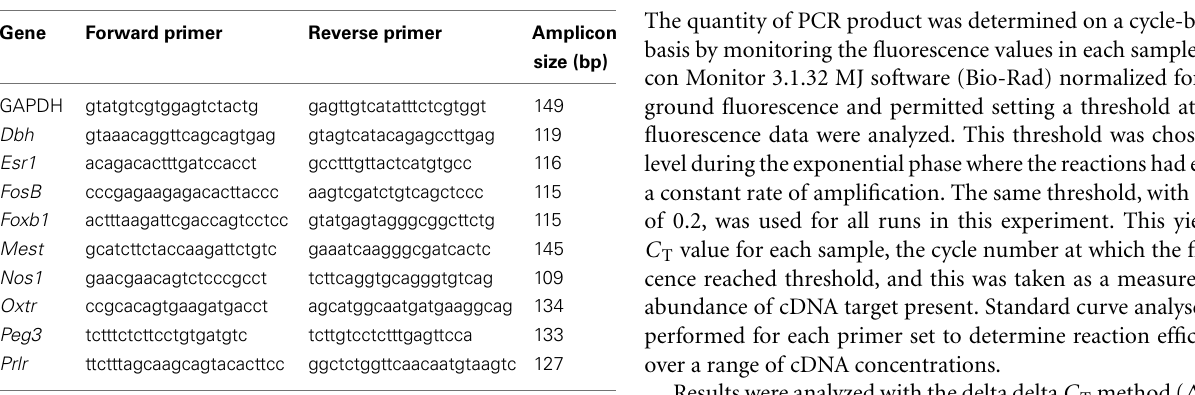
FIGURE 1 | Schematic of mouse olfactory circuits. Main olfactory pathway is shown in red, accessory olfactory pathway in blue, back projections in green, and intracortical projections in purple. Regions highlighted in gray were analyzed in this study. Adapted in part from (Dulac andWagner, 2006; Baum and Kelliher, 2009; de Castro, 2009). Abbreviations: aLA, anterior lateral amygdala; aMA, anterior medial amygdala; AOB, accessory olfactory bulb; AON, anterior olfactory nucleus; AOT, accessory olfactory tract; BST, bed